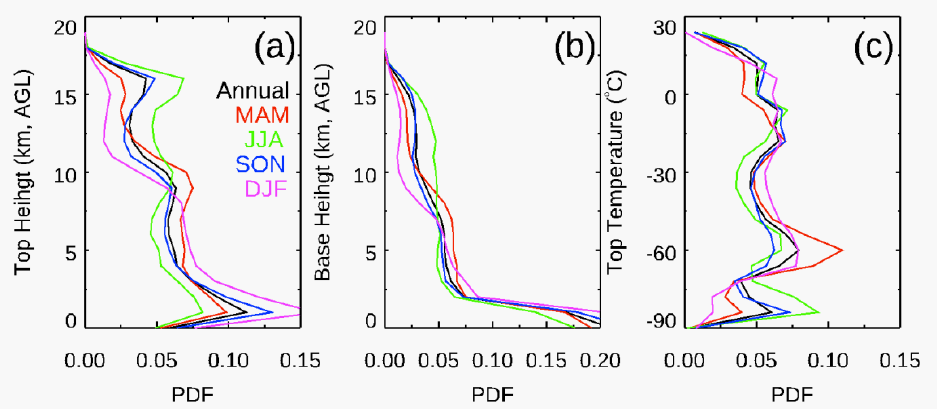
Figure 5. Probability distribution functions (PDF) of ( a ) cloud-top height, ( b ) base height, and ( c ) top temperature and their seasonal variations. Cloud-top and base heights have a bin size of 1 km, and their top temperature has a bin size of 6 °